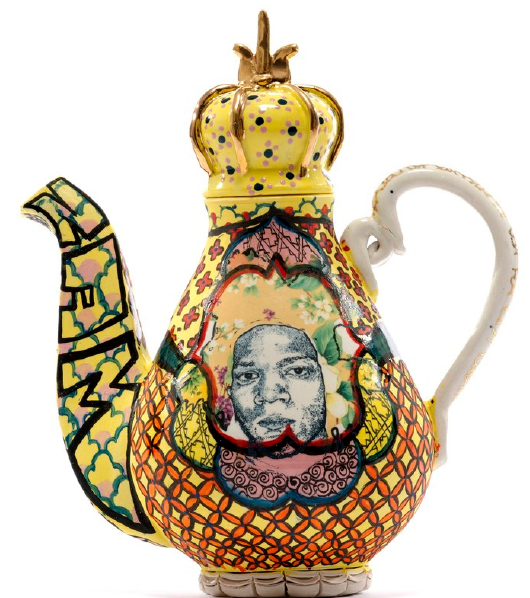
Figure 11. Basquiat/Celia Cruz Teapot , 2016 Porcelain, china paint, gold luster, 12 × 10 × 6 1/2 in. Image by KeneK Photography, courtesy of Wexler Gallery.